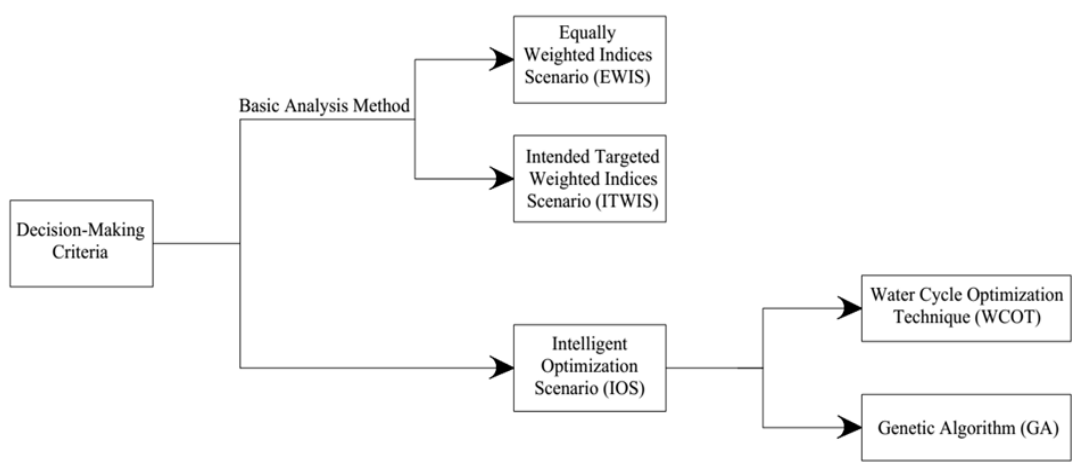
Figure 3. Different scenarios for obtaining the optimum solution.